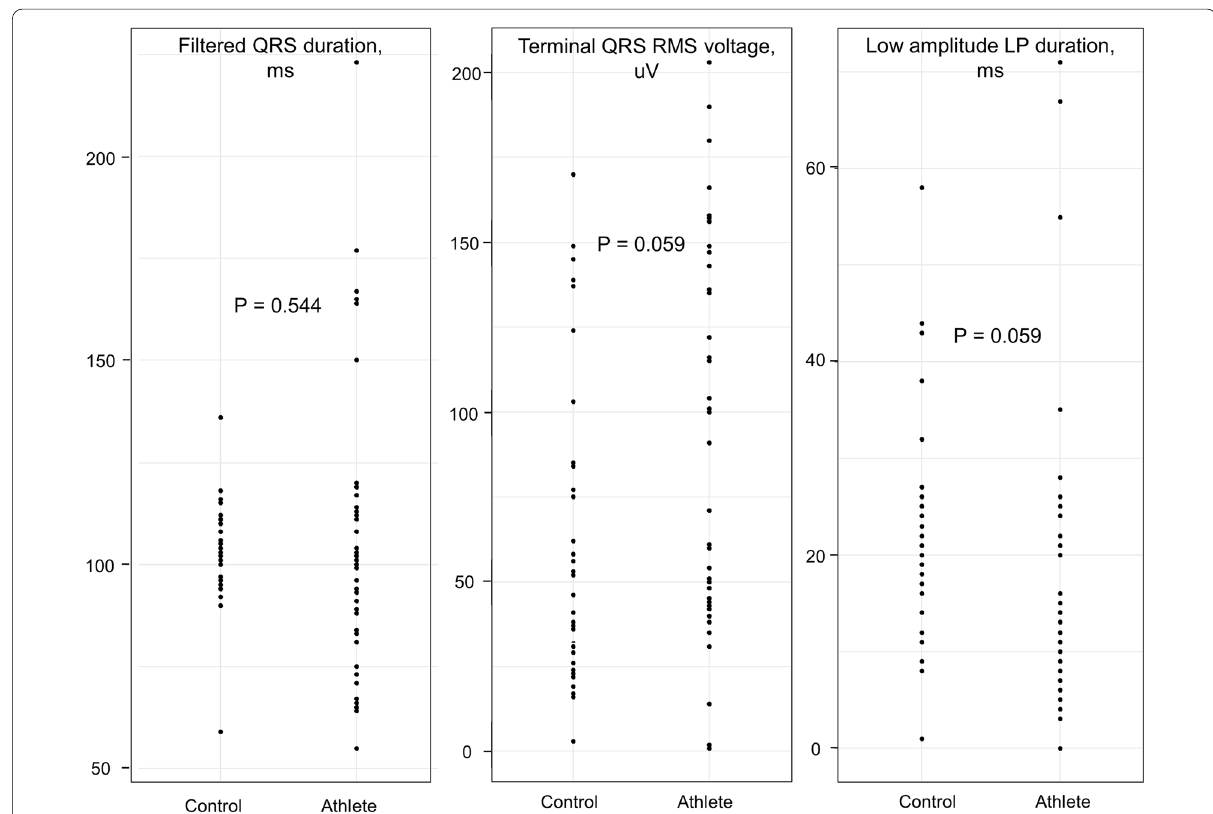
Fig. 2 Comparison of each signal‑averaged electrocardiographic parameters between professional athletes and controls